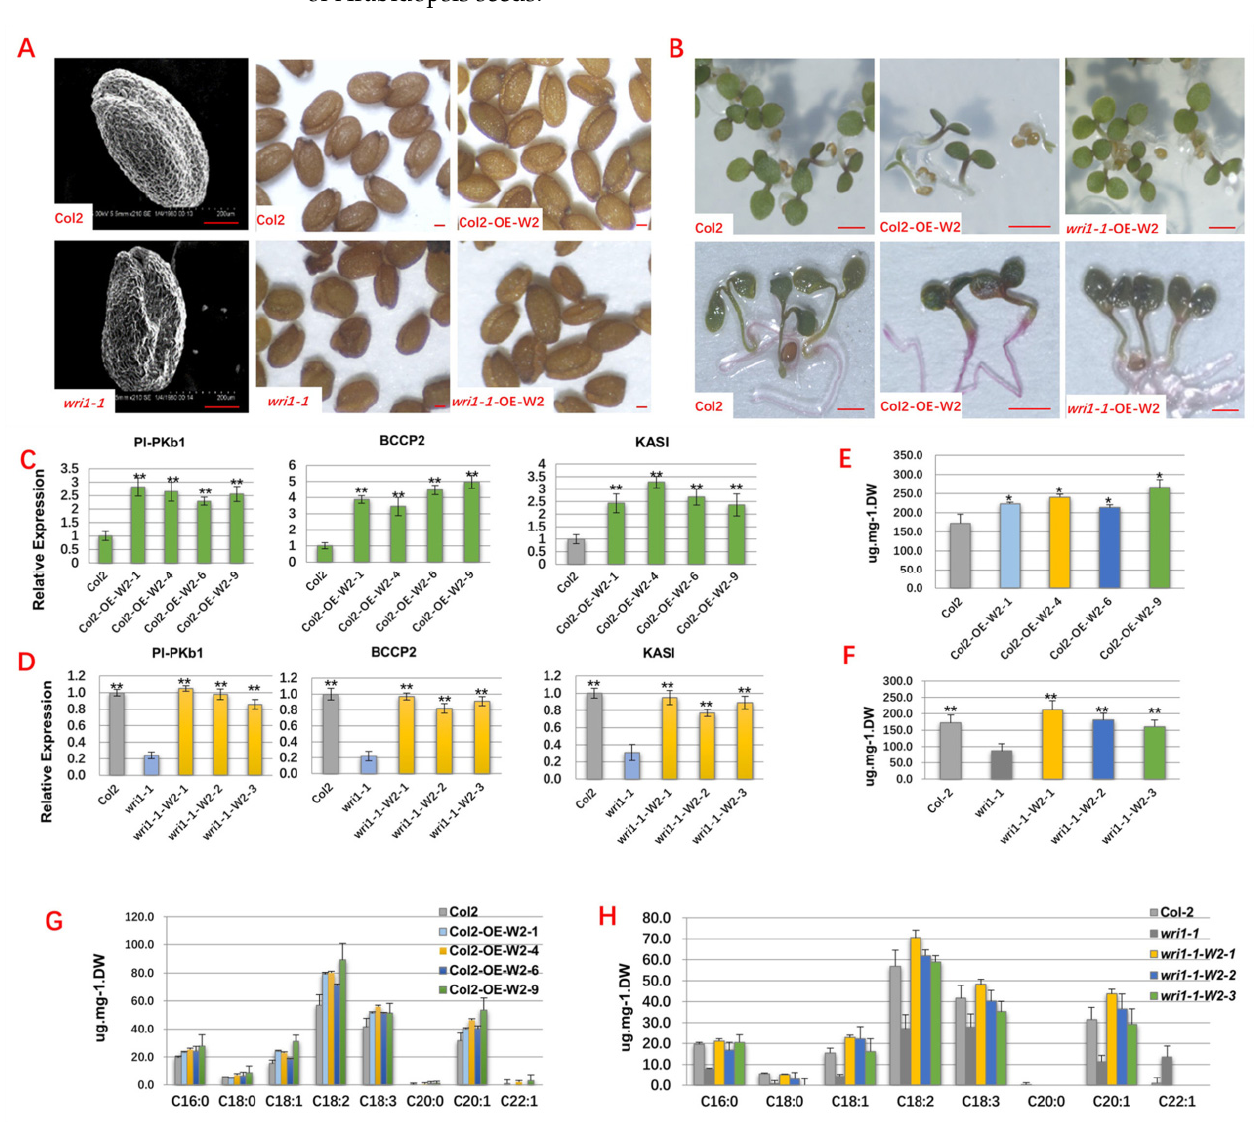
Figure 5. Functional analyses of TaWRI1Ls in the Arabidopsis mutant. ( A ) Seeds of Col2, wri1-1 mutant, and their respective OE lines. Bar = 100 µm. ( B ) Upper: seedlings of Col2, wri1-1 mutant, and their respective OE lines; lower: seedlings of Col2, wri1-1 mutant, and their respective OE lines stained with Sudan Red 7B. Bar = 500 mm. ( C ) Expression of Pl-PK β 1 , BCCP2 , and KASI in Col2 and its OE lines. ( D ) Expression of Pl-PK β 1 , BCCP2 , and KASI in wri1-1 and its OE lines. ( E ) Seed fatty acid contents of Col2 and its OE lines. ( F ) Seed fatty acid contents of wri1-1 and its OE lines. ( G ) Seed fatty acid components of Col2 and its OE lines. ( H ) Seed fatty acid components of wri1-1 and its OE lines. Data are represented as means ± SD from independent biological replicates, and p -values are indicated by Student’s t -test (* p < 0.05, ** p < 0.01).